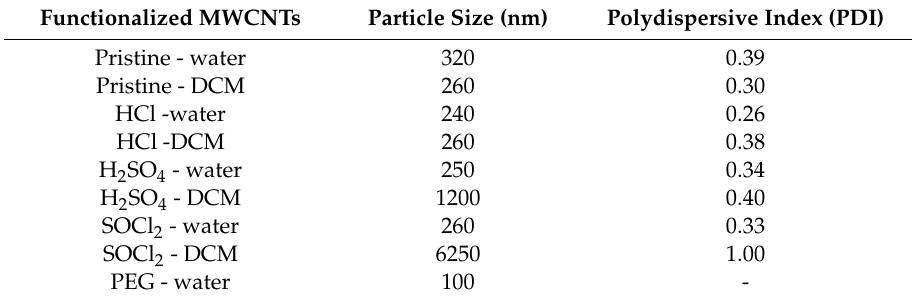
Table 2. Particle size and polydispersive index of the functionalized MWCNTs in water and dichloromethane (DCM). Functionalized MWCNTs Particle Size (nm) Polydispersive Index